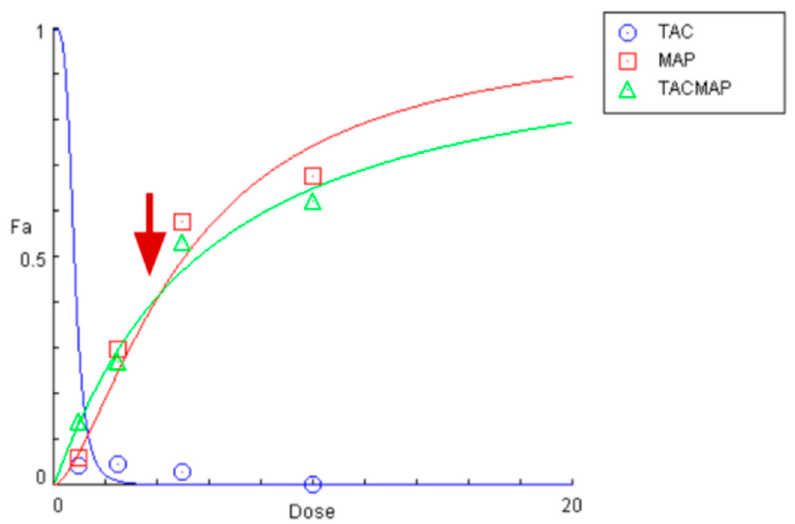
Figure 9. Dose-effect curves of Tacrine, MAP, and MAP-tacrine estimated by the unified theory using CompuSyn software. The dose was plotted on the y -axis as a function of effect level (Fa) on the x -axis to assess each drug behavior. Doses below the red arrow indicate better activity of Tacrine-MAP conjugate than MAP and tacrine alone.Experiments were conducted in triplicate ( n = 3).